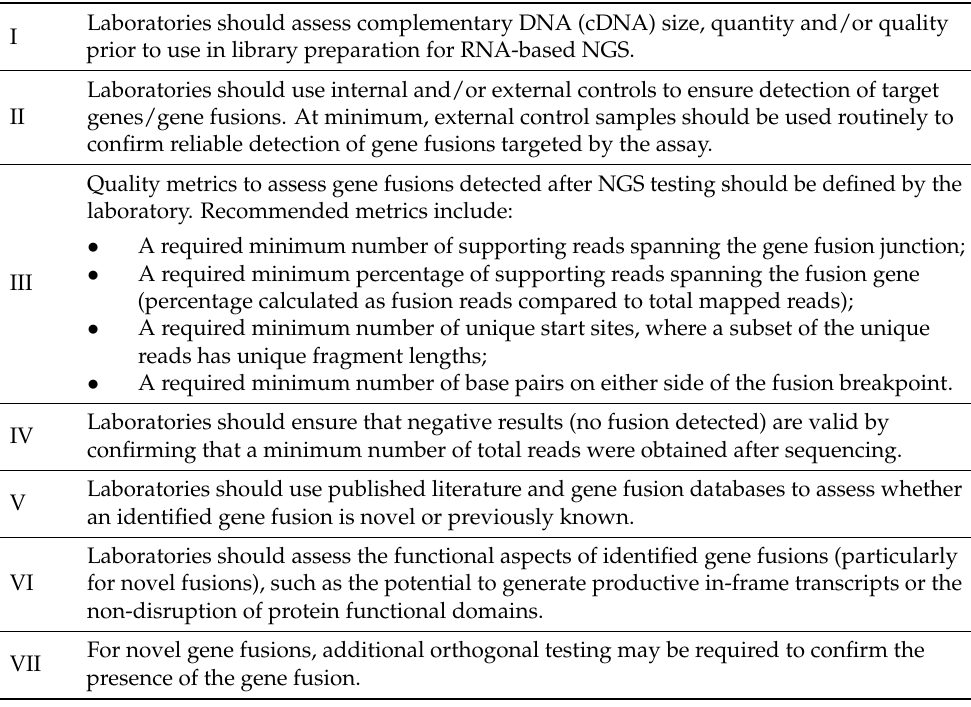
Table 2. Summary of the analytical and interpretive recommendations for RNA-based NGS for gene fusion